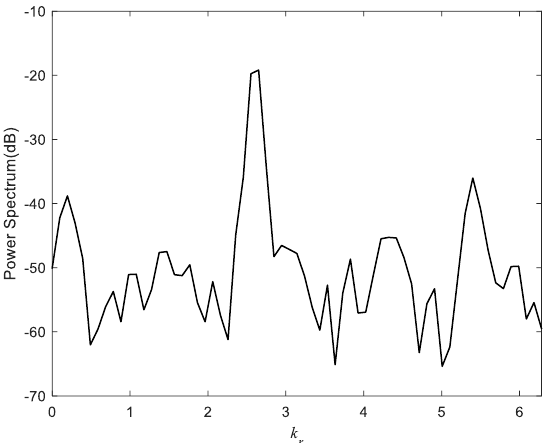
Figure 3. The horizontal wavenumber spectrum of the first-time step. The maximum value is at k = 2 . 651